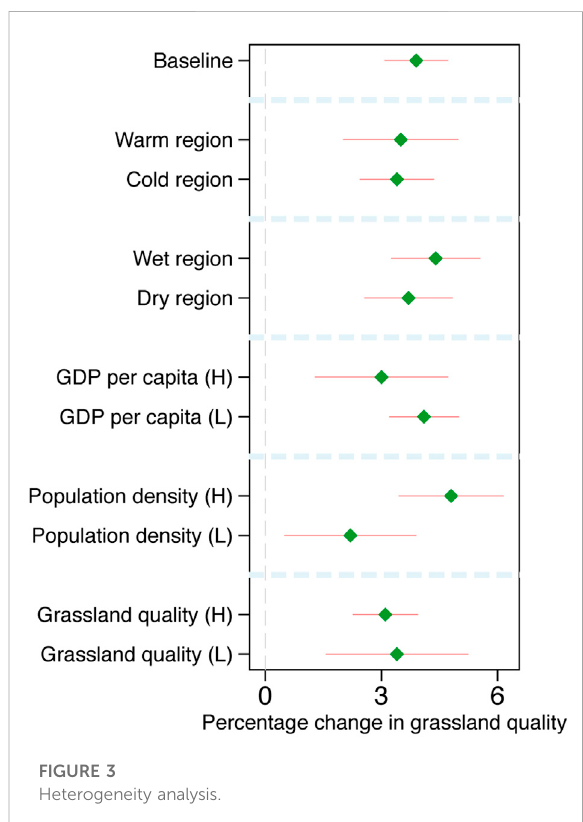
FIGURE 3 Heterogeneity